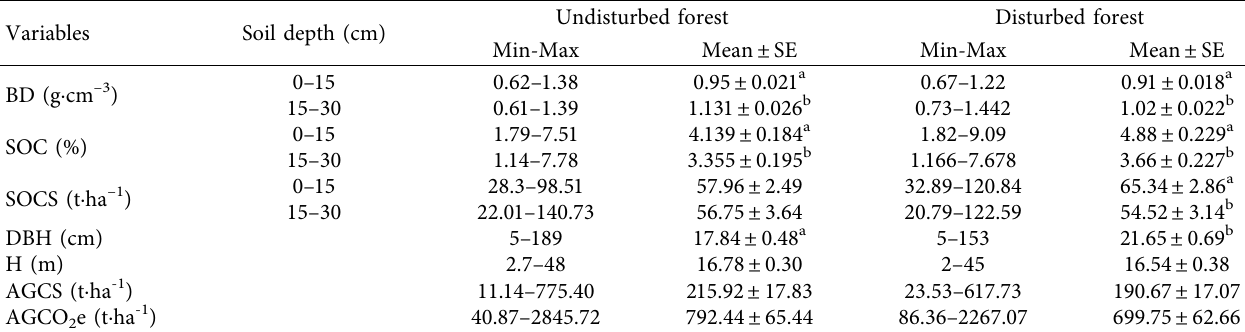
Table 3: Variation of SOCS between AGCS in undisturbed and disturbed forests (key: SOCS � soil organic carbon stock; AGCS � aboveground carbon stock; AGCO2e � aboveground carbon dioxide equivalent; BD � bulk density, SOC (%) � soil organic carbon concentration; DBH � diameter at breast height, H � total height). Different letters in the column of variables show a significant difference at a 5% significance